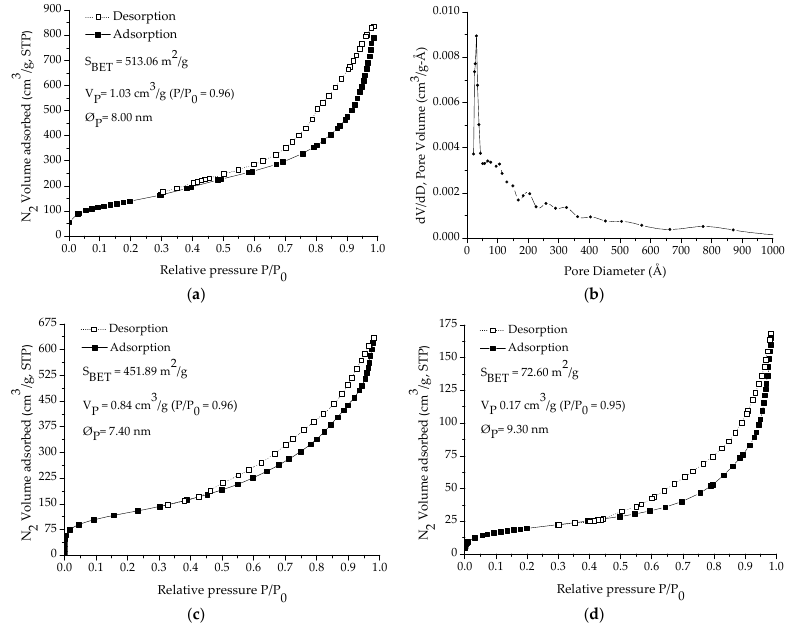
Figure 4. N 2 adsorption-desorption isotherm ( a ) and pore size distribution ( b ) of HMSN after calcination. N 2 adsorption-desorption isotherms after loading with inhibitor ( c ) and after encapsulation with PDDA ( d ). S BET : Specific surface area, V p : Pore volume, and φ p : Pore diameter. In Figure 5, the average ζ -potential values of the HMSN at each different stage are presented. As can be observed, nanoparticles of the silica shell on the PMA template (before calcination) present a positive zeta potential (+31.0 mV) due to the still presence of the surfactant structure in the pores. However, after calcination and removal of both the surfactant molecules and core template, the ζ - potential of the empty HMSN shifted to negative values ( − 28 mV). After loading the inhibitor, a minor decrease (up to − 34.2 mV) was measured. In contrast, deposition of the PDDA layer led to a noteworthy change to positive values (+57.8 mV). Therefore, successful encapsulation of the active inhibitor inside the HMSN structure was confirmed, as well as the presence of the external PDDA layer deposited on the silica shell surface. Figure 5. ζ -Potential values of HMSN at each different stage. Results of the inhibitor release as a function of the pH are presented in Figure 6. As can be observed, from pH 3 to pH 9 the inhibitor release is almost completely prevented. On the other hand, from pH = 9, a progressive increase of inhibitor discharge was observed. At pH = 13 it may be considered that the full amount of inhibitor loaded into the nanoparticles has been completely released. At this pH neither the PDDA layer nor the silica are stable. As release takes place under alkaline conditions, but loading is favoured under acidic ones, the reversibility of the process is strongly hindered, thus, allowing that, once released, the corrosion inhibitor can act in the affected area and the discharge is only stopped when the pH decreases sufficiently. Therefore, the smart release of the inhibitor from HMSN as a function of pH has been clearly confirmed.